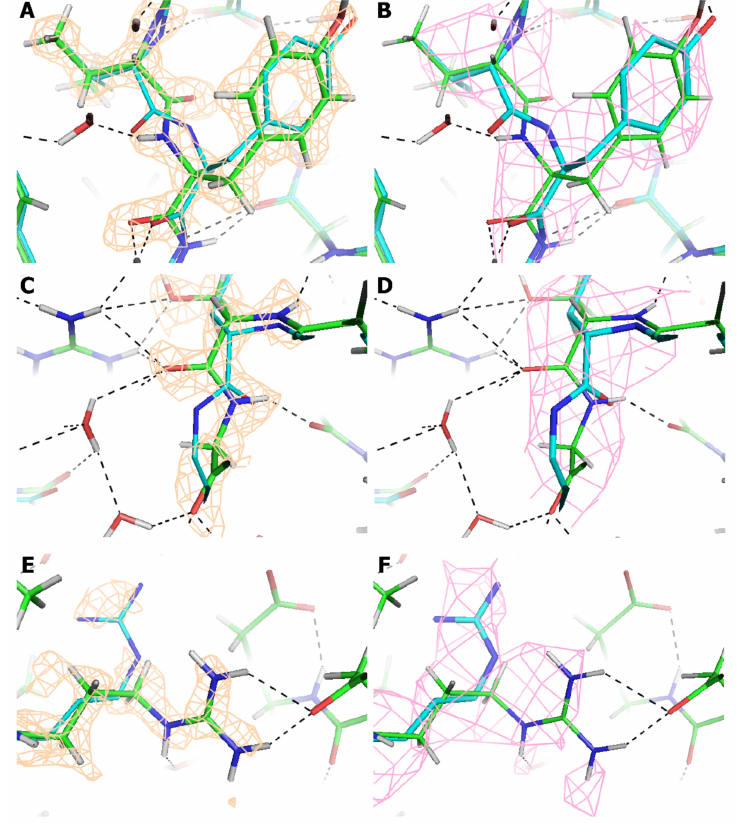
Figure 4. Improvements in the structure between 2.8 Å and 1.56 Å resolution. Paired images show the 1.56 Å (brown, left) and 2.8 Å (pink, right) reconstructions with the refined atomic models with green C α (1.56 Å) or cyan (2.8 Å). ( A , B ) Peptide bond Val 613 -Tyr 614 , both maps contoured at 2.0 σ . ( C , D ) Peptide at the tight turn Thr 407 -Gly 408 , both maps contoured at 1.5 σ . ( E , F ) Side chain of Arg 391 , both maps contoured at 1.1 σ